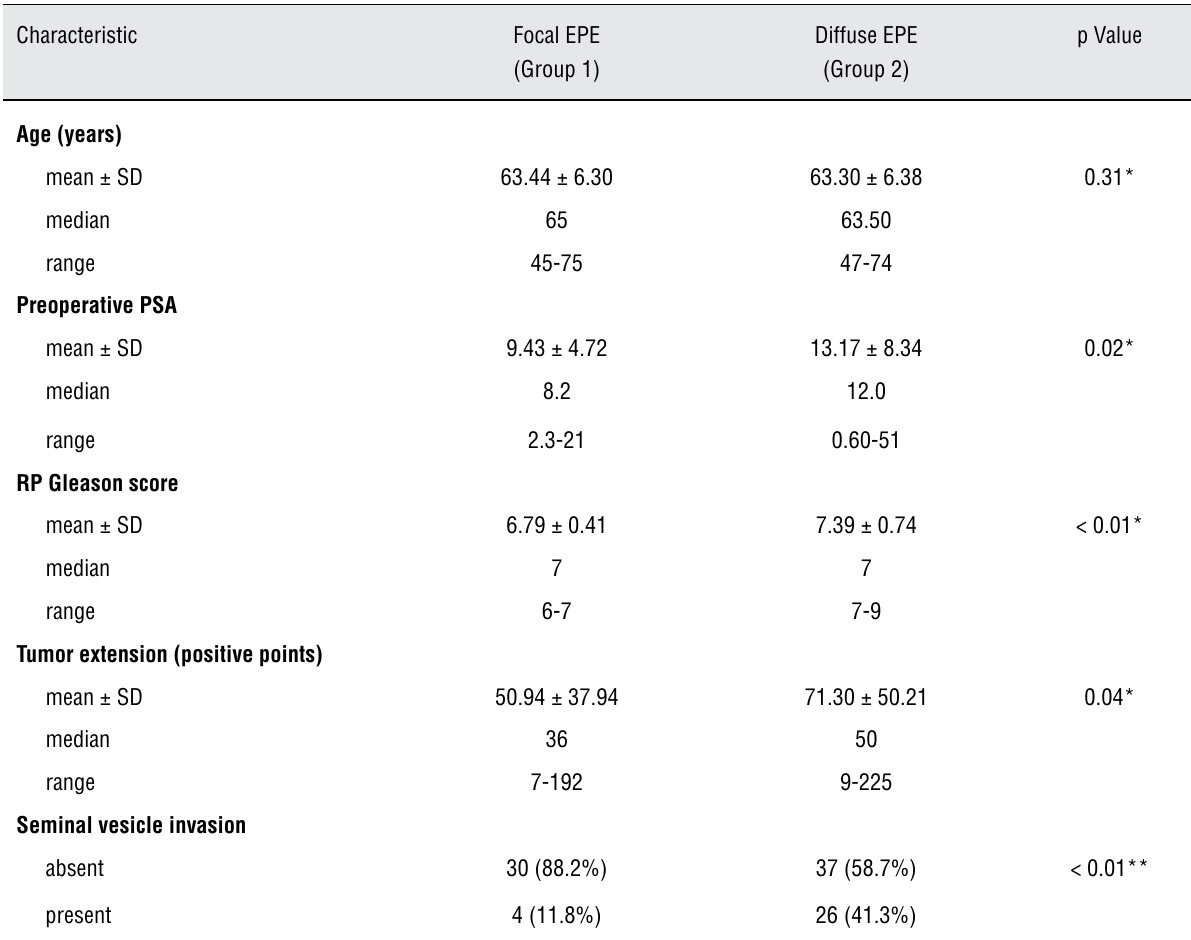
Table 1 - Clinicopathological features comparing 39 patients with focal EPE (Group 1) vs. 90 patients with diffuse EPE (Group 2).